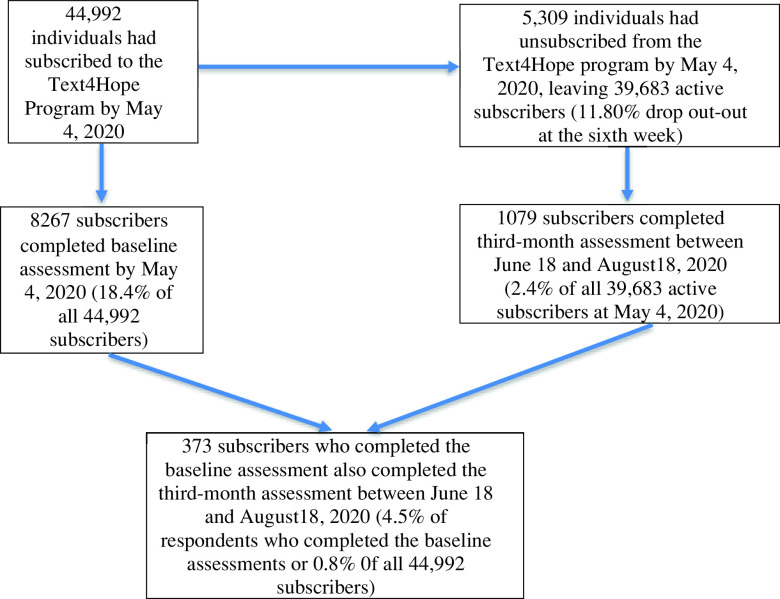
Subscriber flowchart.